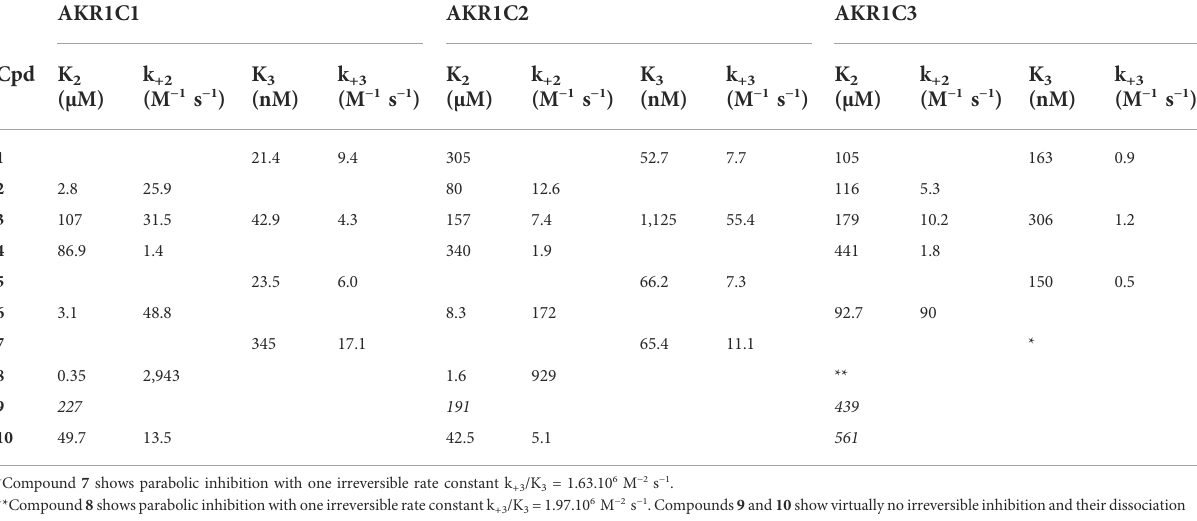
TABLE 1 Inhibition and rate constants for complexes 1 –